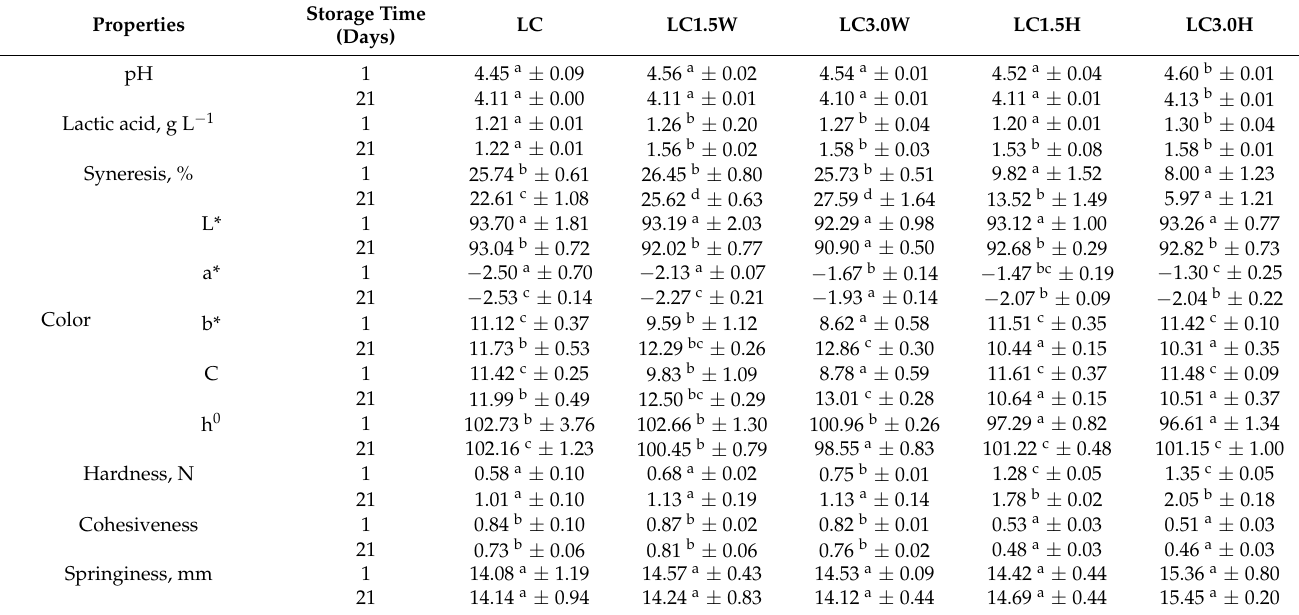
Table 1. Acidity, syneresis, color and texture of sheep’s milk fermented by Lacticaseibacillus casei .